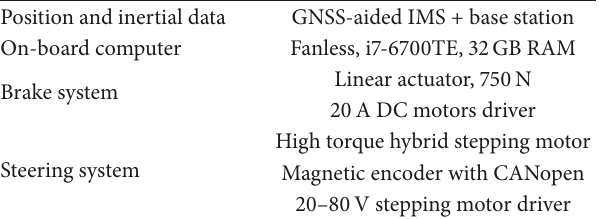
Table 2: Sensors and electronic devices.